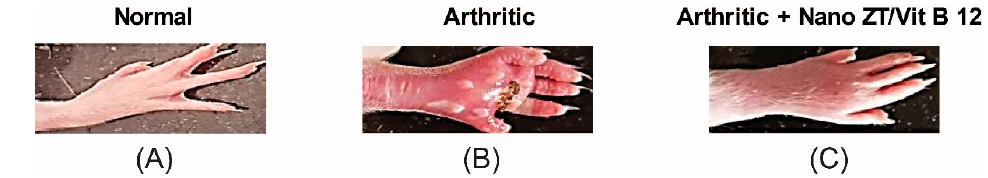
Figure 7. The gross morphology of rats’ right hind paws and ankles reveals swelling and inflamma- tion in rats of different groups. ( A ) Normal rats, ( B ) arthritic rats, and ( C ) arthritic rats received Nano T/Vit B 12.